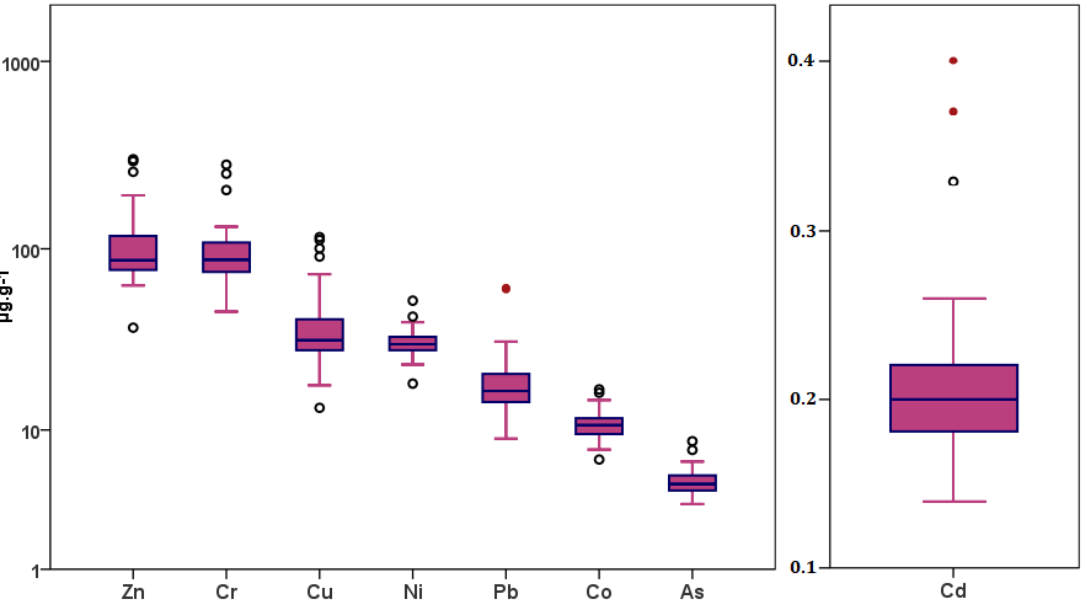
Figure 2. Box plot of the TE concentrations in bottom sediments from the Sebou basin. Notice that concentrations are expressed in log, except for Cd. concentrations are expressed in log, except for